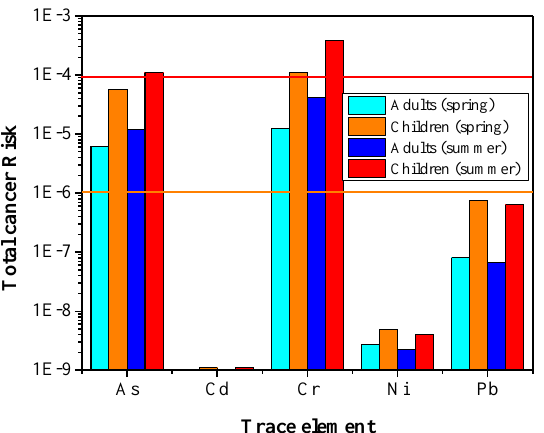
Figure 7. Total cancer risk values of selected heavy metals in Asaluyeh for adults and children. The orange and red lines denote the lower and upper safe limits, respectively.